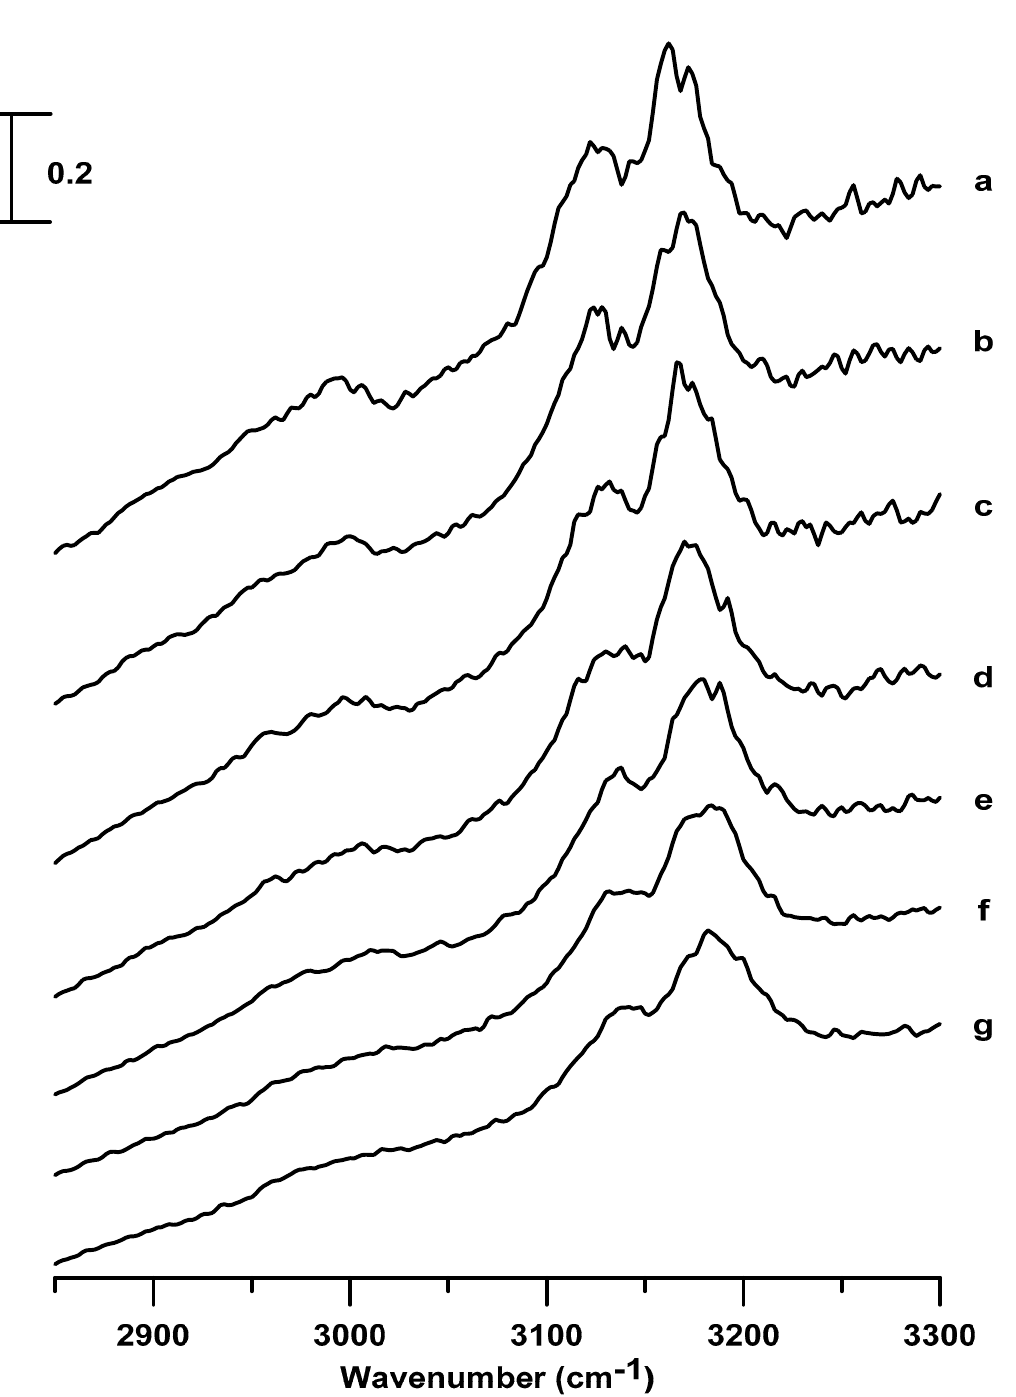
Figure 3. Infrared spectra of [C 2 C 1 Im][BF 4 ] in a silica matrix obtained at (a) ambient pressure and at (b) 0.4, (c) 0.7, (d) 1.1, (e) 1.5, (f) 1.8, and (g) 2.5